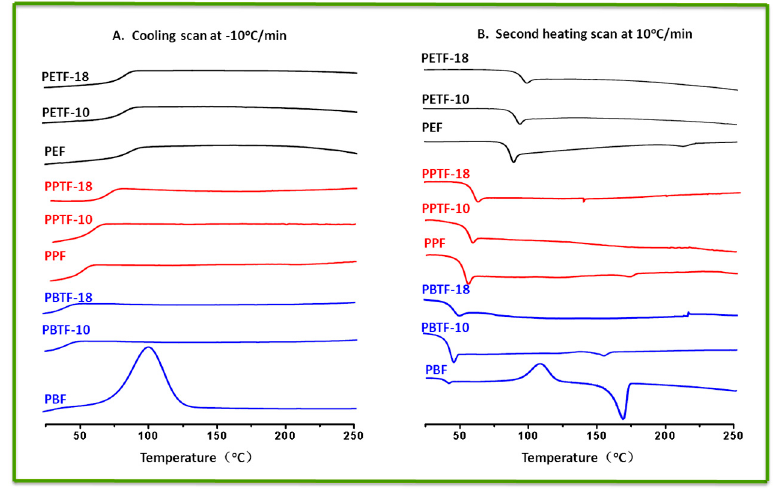
Figure 3. DSC curves for PEF, PPF, PBF, and the copolyesters modified with CBDO.